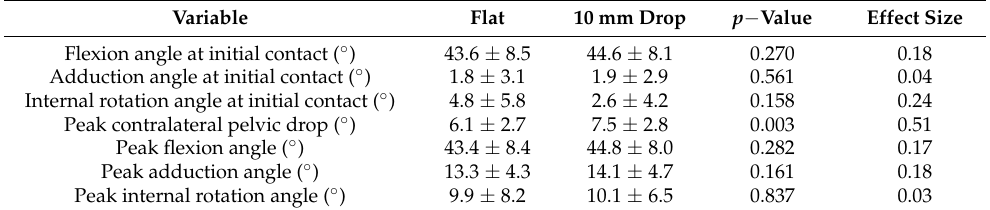
Table 2. Comparison of hip kinematics between flat shoes and conventional shoes with a 10 mm